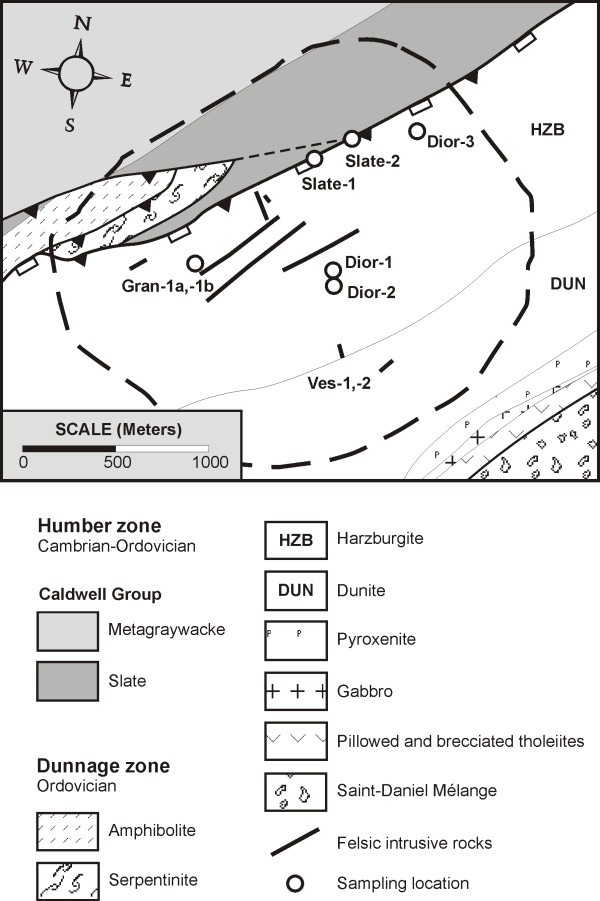
Geology of the Asbestos ophiolite in the area of the JM Asbestos mine, Asbestos, Québec (After maps by Johns-Manville Inc, Bédard et al. [18], Hébert [19]). The contact between the ophiolite and the Caldwell Group metasediments shows evidence of earlier thrusting and later normal faulting.